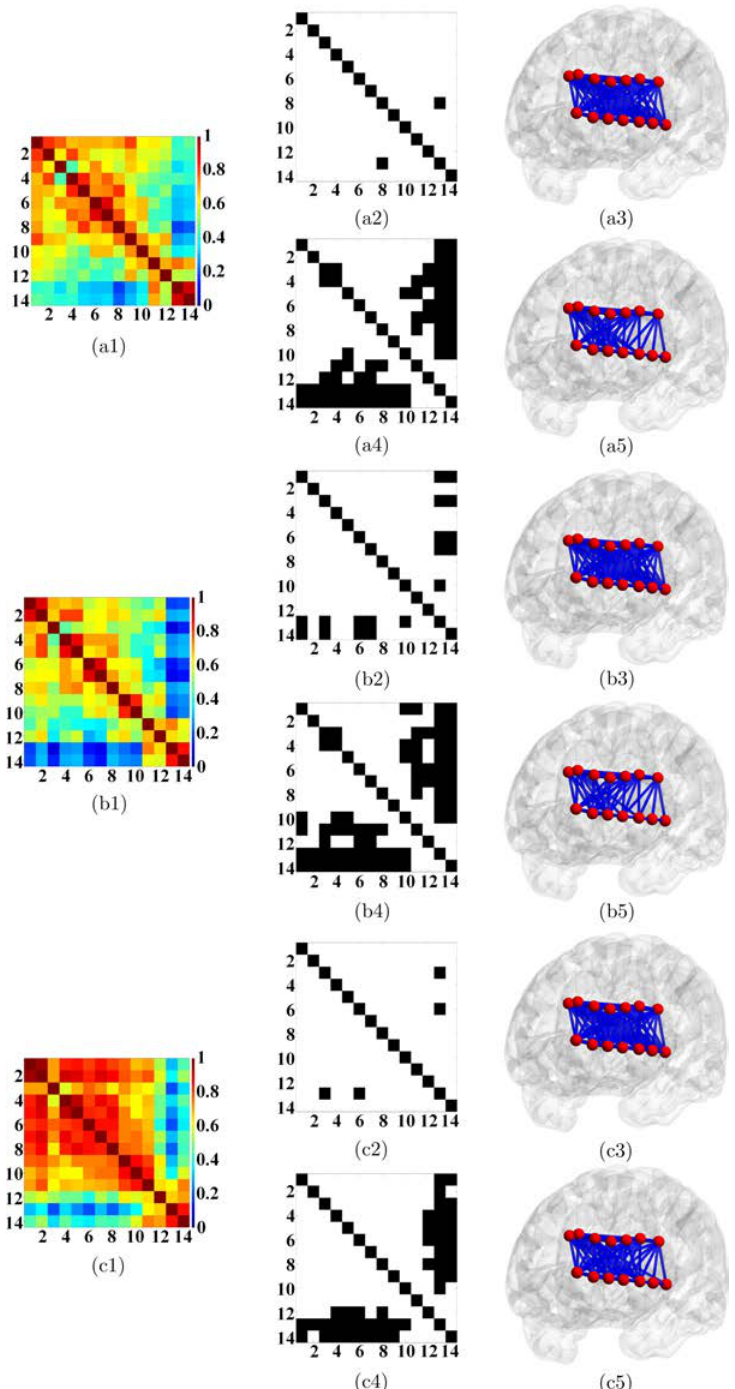
Fig. 3. Correlation coe±cients, binary matrix and 3D relative networks of brain nodes for the transcoding, code-mixing and transphrasing translation strategies. (a1) – (a5) are for the transcoding case: (a1) are the correlation coe±cients, (a2) and (a3) are the binary matrix and brain network with the threshold value of 0.2, and (a4) and (a5) are the binary matrix and brain network with the threshold value of 0.5. (b1) – (b5) are for the code-mixing case: (b1) are the correlation coe±cients, (b2) and (b3) are the binary matrix and brain network with the threshold value of 0.2, and (b4) and (b5) are the binary matrix and brain network with the threshold value of 0.5. (c1) – (c5) are for the transphrasing case: (c1) are the correlation coe±cients, (c2) and (c3) are the binary matrix and brain network with the threshold value of 0.2, and (c4) and (c5) are the binary matrix and brain network with the threshold value of